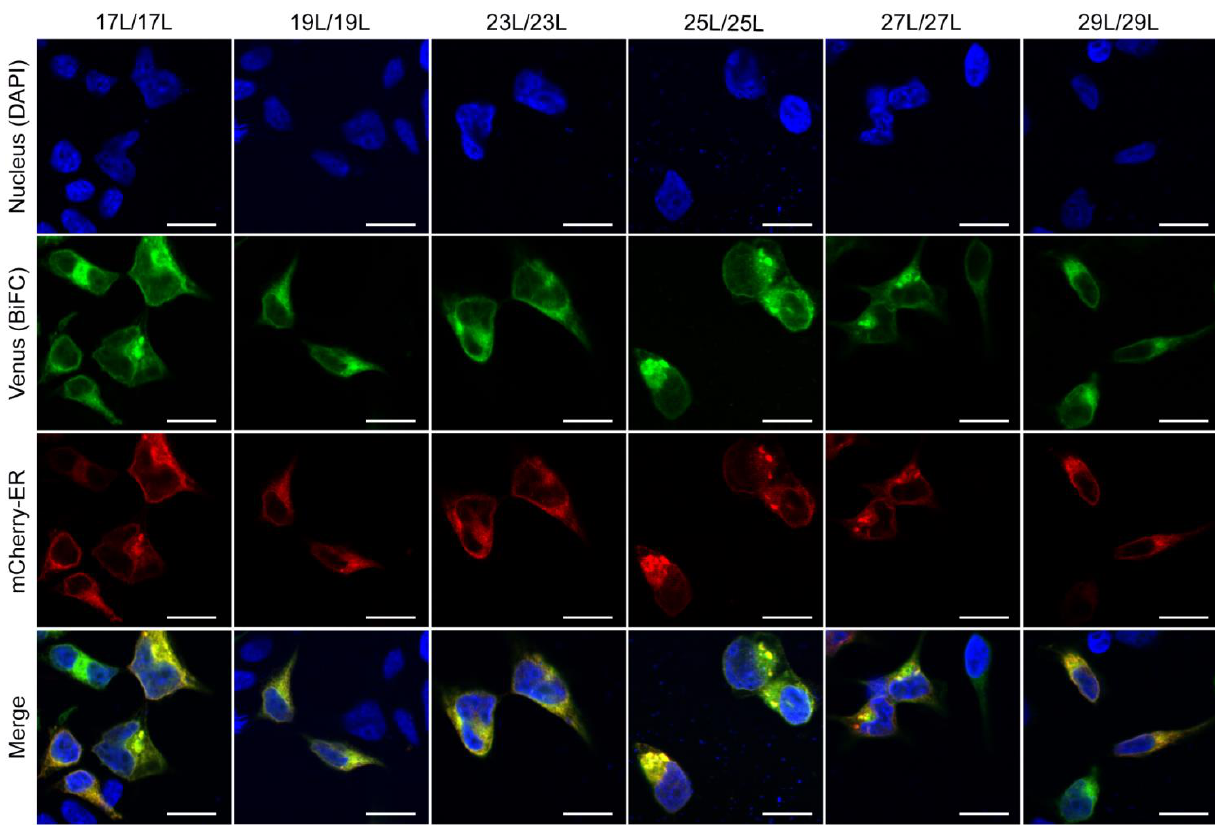
FIGURE 10: Homo-dimerization at the endoplasmic reticulum. Confocal microscopy of DAPI stained (blue) HEK293T cells expressing tested homo- dimers (17L [VN-17L/VC-17L], 19L [VN-19L/VC-19L], 23L [VN-23L/VC-23L], 25L [VN-25L/VC-25L], 27L [VN-27L/VC-27L], 29L [VN-29L/VC-29L]). TM- driven homo-oligomerization results in VFP reconstitution and fluorescent signal (green). Sec61α fused to mCherry fluorescent protein was used as ER marker (red). The presence of colocalization of red and green signals in the merge images was highlighted in yellow. Scale bar size was set to 16